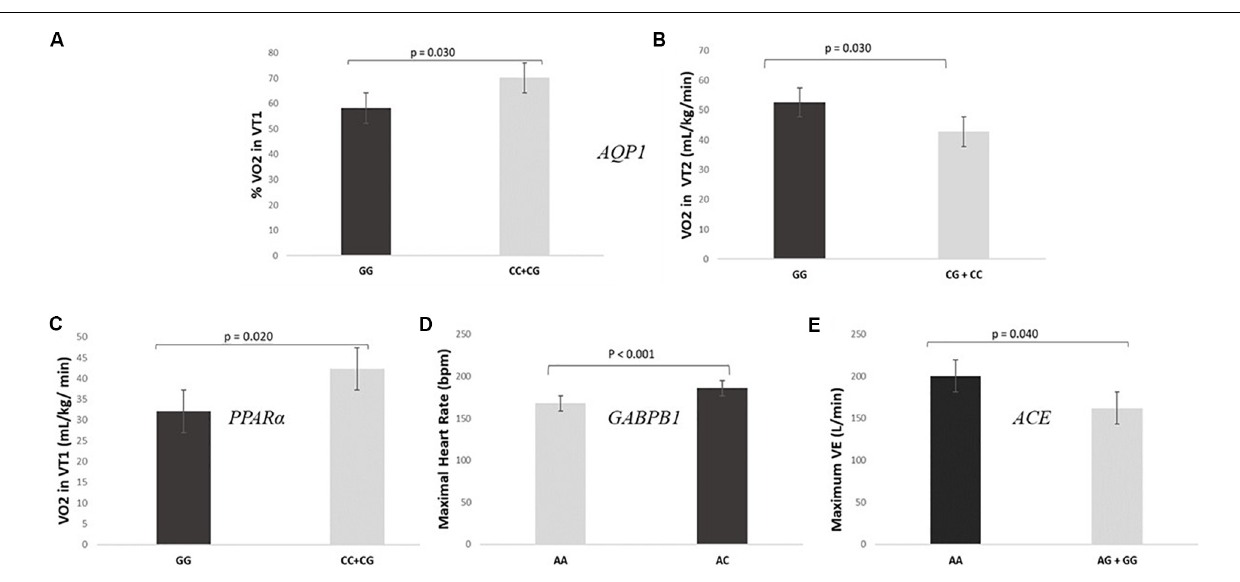
FIGURE 2 | SNPs included in the prediction algorithm GES individually associated to specific parameters related to individual performance. (A,B) Levels of VO 2 and% VO 2 in VT1 during the cardiopulmonary exercise test according to AQP1 rs1049305. (C) Levels of VO 2 in VT2 during the cardiopulmonary exercise test according to PPAR α rs4253778. (D) Maximal heart rate during the cardiopulmonary exercise test according GABPB1 rs12594956. (E) Maximum minute ventilation (VE) during the cardiopulmonary exercise test according ACE